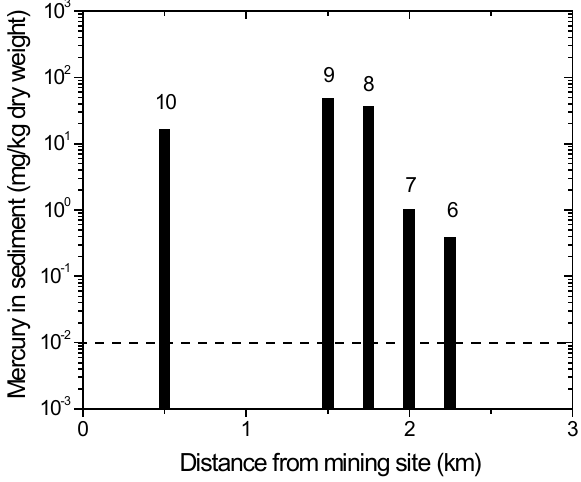
Figure 6. Mercury content in sediment of Anggrek Rivers. Numbers on top of bars correspond with sampling location. The dotted line indicates the recommended safety level (WHO/ICPS 1990).